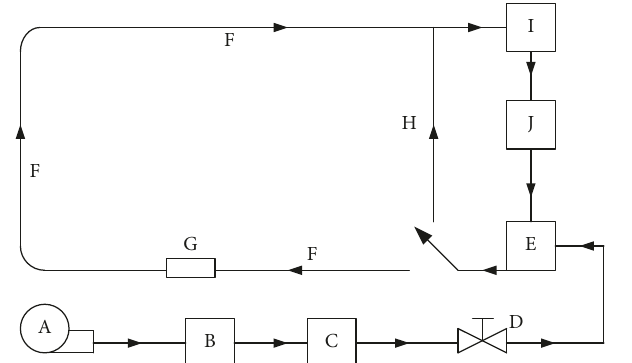
Figure 1: Schematic diagram of the experimental system: A: air compressor, B: gas tank, C: air dryer, D: regulating valve, E: screw feeder, F: transport pipeline, G: acoustic sensor, H: removing blockage pipeline, I: solid storage silo, and J: weighing